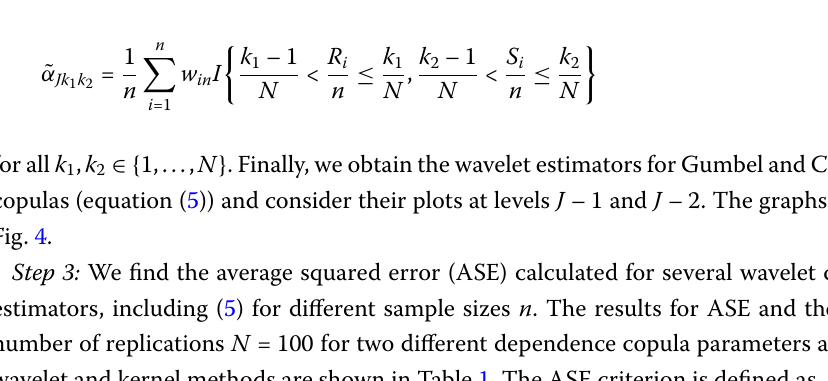
Step 3: We find the average squared error (ASE) calculated for several wavelet copula estimators, including (5) for different sample sizes n . The results for ASE and the total number of replications N = 100 for two different dependence copula parameters and for wavelet and kernel methods are shown in Table 1. The ASE criterion is defined as 1 ASE =